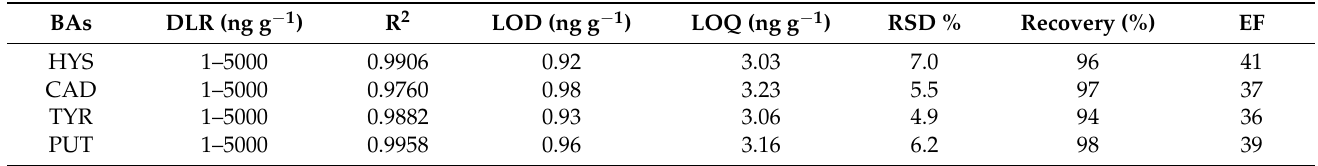
Table 1. Figures of merit of the proposed technique to measure BAs in non-alcoholic beer samples.